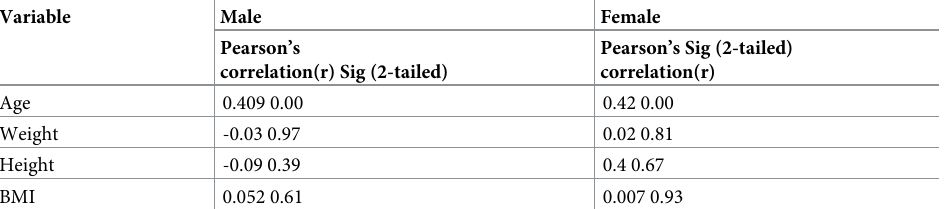
Table 6. Summary of correlation between common bile duct diameter, age and anthropometric measurements by sex.